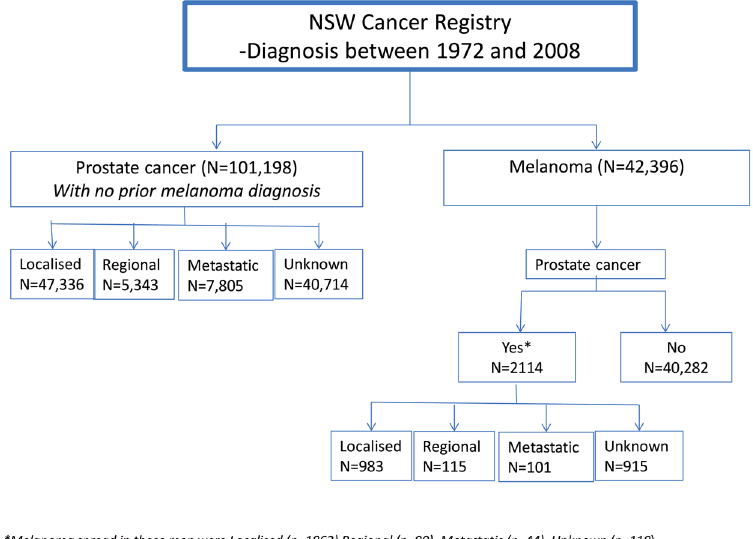
Figure 1. Flow diagram showing the breakdown by disease spread for all melanoma and prostate cancer cases registered in the New South Wales Cancer Registry between 1972 and